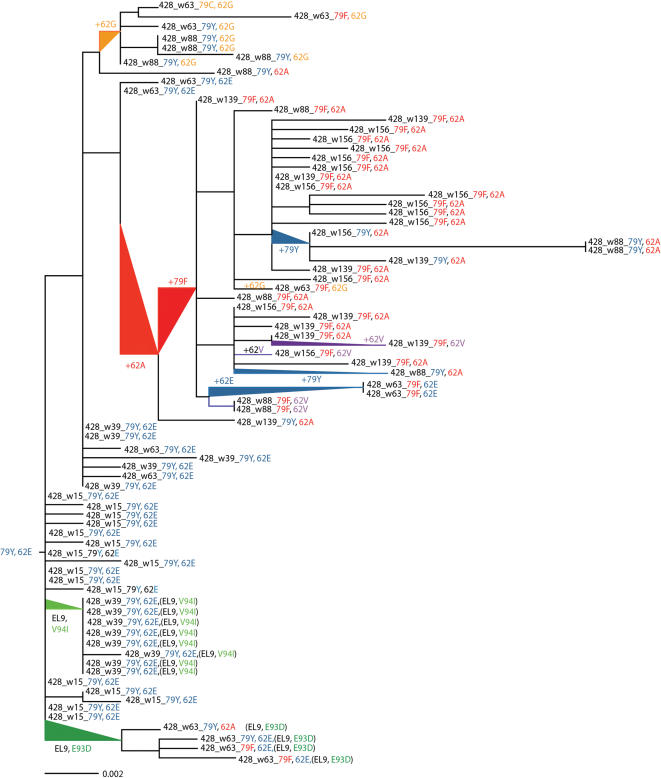
Phylogenetic tree illustrating viral evolution of the HIV-p17 gag region (HXB2 coordinates 790–1431) in subject OP428 under selective pressure.Positively selected amino acid sites within the HLA-A2 ((SL9, 77SLYNTIATL85 (patient consensus)), HLA-A1 (GY9, 71GSEELRSLY79), and HLA-B8 (EL9, 93EVKDTKEAL101) restricted epitopes. Amino acids corresponding to the consensus B sequence are shown in blue, while the Y79F mutation within SL9 and GY9 is given in red, and the E93D and V94I mutations within EL9 are shown in green on the tree. The variation found at the positively selected amino acid position 62, where a potential compensatory mutation (E62A) seems to occur prior to, and associated with, the Y79F substitution are as follows: variation at position 62: E, blue, G, orange, V purple and A red. Amino acid numbering corresponds to HXB2 Gag. Scale bars signify substitutions/site. w: corresponds to estimated week from infection (e.g. a clone named 428_w15 was obtained from a plasma sample drawn at week 15).